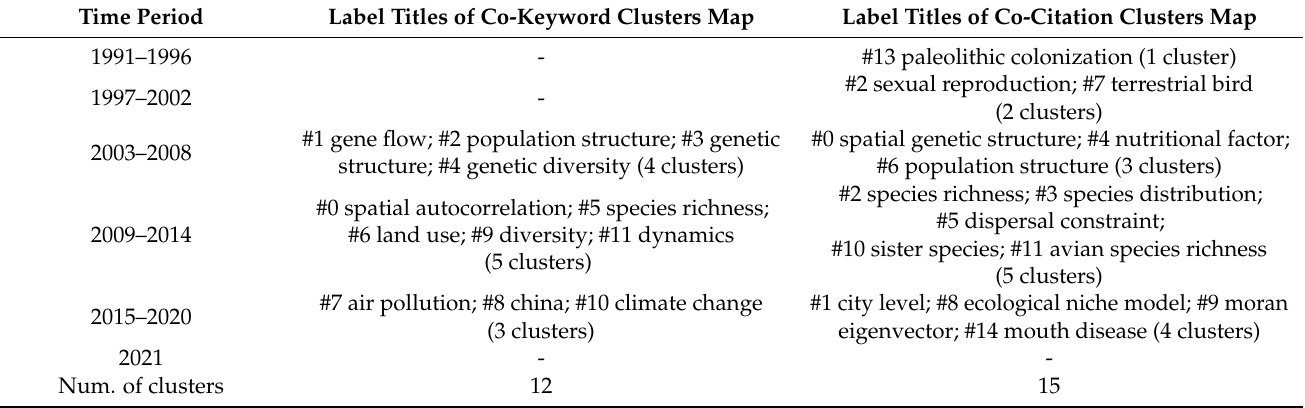
Table 5. Label titles of clusters in Figure